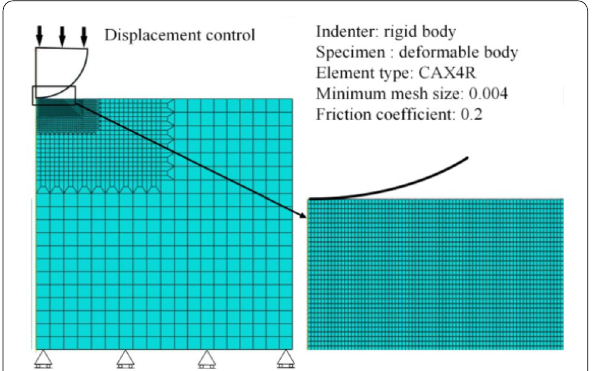
Figure 2 Finite element model of spherical indentation